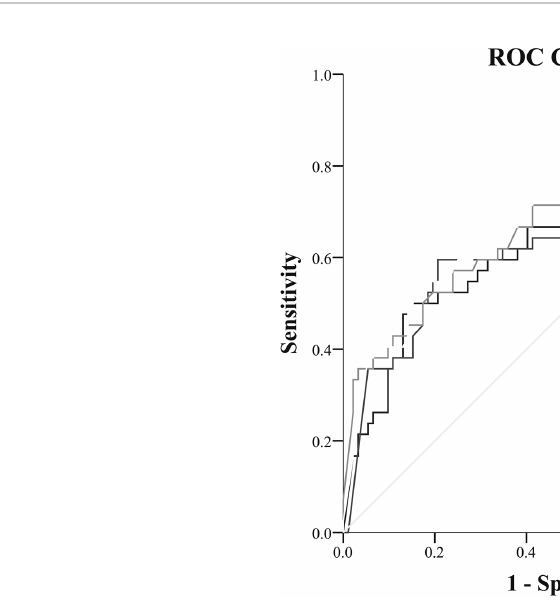
FIGURE 1 | Receiver-operating characteristic (ROC) analysis of SSR to predict DCAN in patients with T2DM [(upper limb amplitude: AUC = 0.70; 95% CI: 0.59 – 0.80; sensitivity, 61.9%; speci fi city, 66.3%, cut-point 1.40 mV, P < 0.001) (lower limb amplitude: AUC = 0.70; 95% CI: 0.60 – 0.80; sensitivity, 66.7%; speci fi city, 68.5%, cut-point 0.85 mV, P < 0.001) (upper limb latency: AUC = 0.67; 95% CI: 0.57 – 0.77; sensitivity, 61.9%; speci fi city, 62%, cut-point 1.40 s, P < 0.05) [lower limb latency: AUC = 0.66; 95% CI: 0.55 – 0.77; sensitivity, 69.0%; speci fi city, 52.2%, cut-point 1.81 s, P <